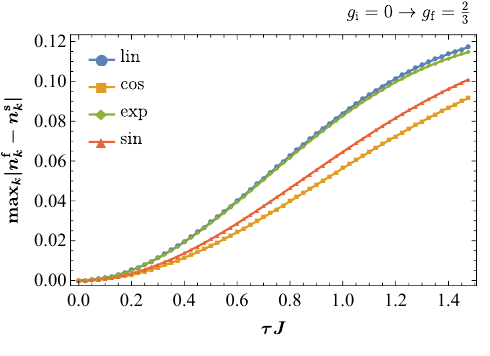
Figure 2: Comparison of the mode occupations n f the sudden-quench result n s